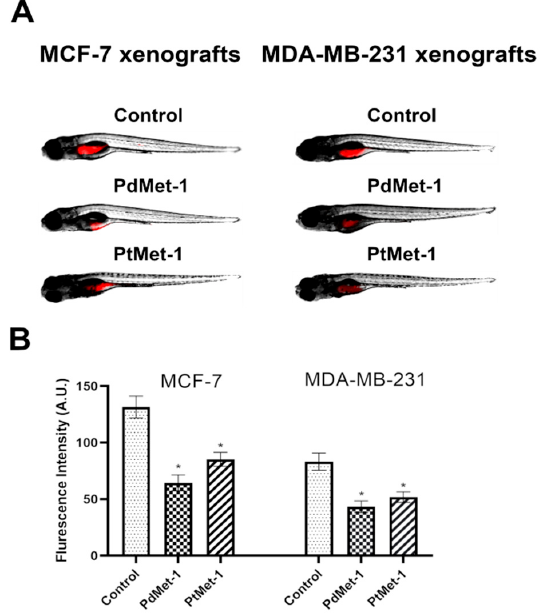
Figure 8. Site-specific injection (yolk sac) of transfected (red) breast cancer cells (MCF-7 and MDA-MB-231) into 48 hpf zebrafish embryos and imaging analysis of tumor growth after 48 h of incubation with PdMet-1 and PtMet-1 (100 µM) ( A ). Quantification of total mCherry fluorescence by breast cancer cells 3 days after injection ( B ) n = 4, * p < 0.05.